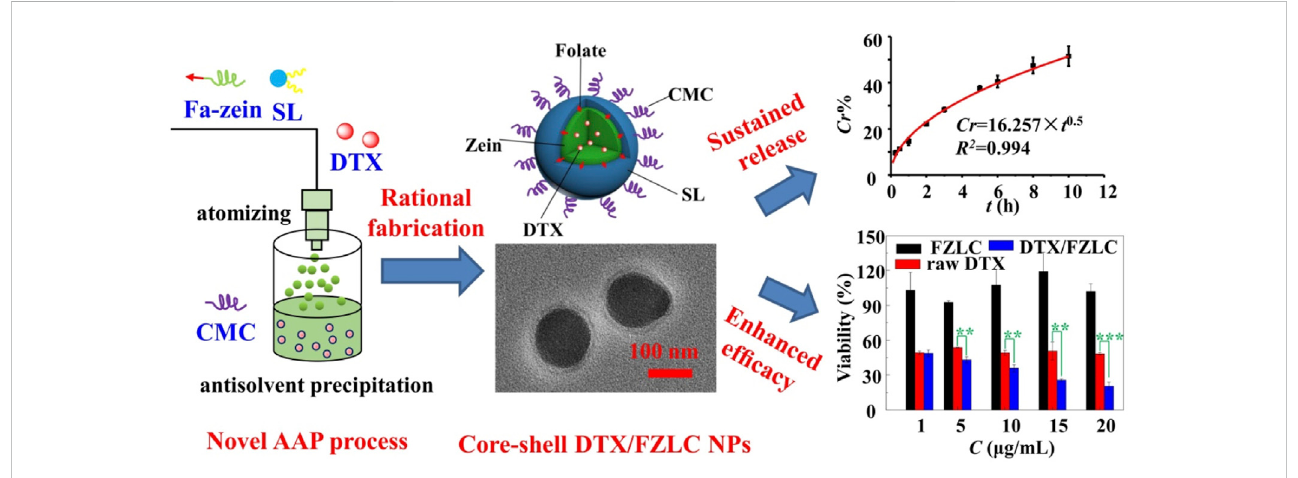
FIGURE 3 Rational fabrication and characteristic of docetaxel loaded folate-conjugated zein/soy lecithin/carboxymethyl chitosan core-shell nanoparticles (DTX/ FZLC NPs) using a novel atomizing/antisolvent precipitation (AAP)